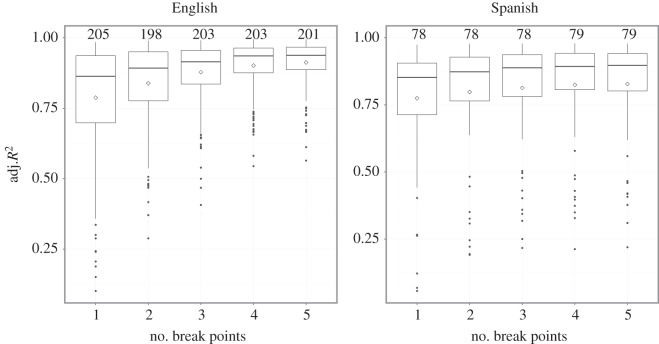
Boxplot of the variance explained (adj.R2) of the viewership time series (up to 50 days after the event) of Wikipedia articles for different numbers of break points. The numbers at the top represent the total count of data points for each model.